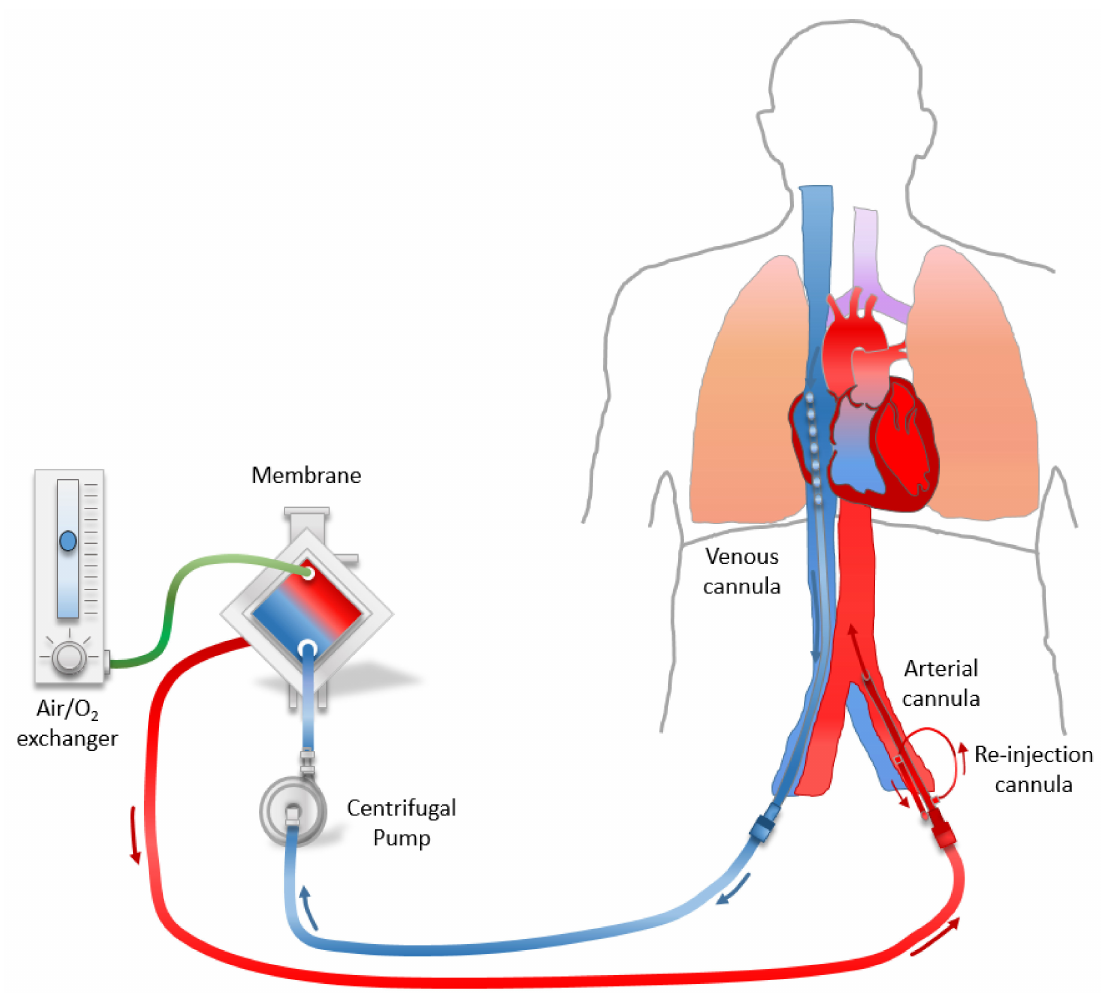
Figure 1. Peripheral f é moro–femoral veno–arterial ECMO used for